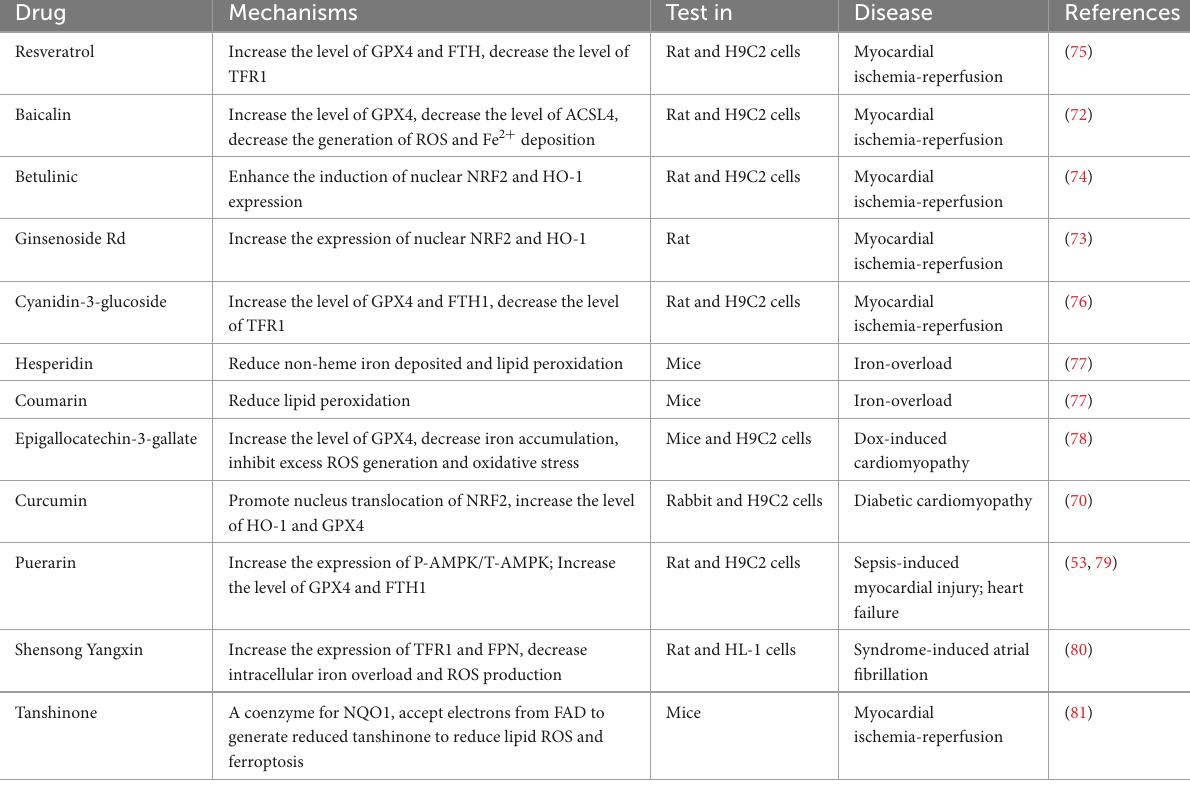
TABLE 1 Summary of traditional Chinese medicine in cardiovascular